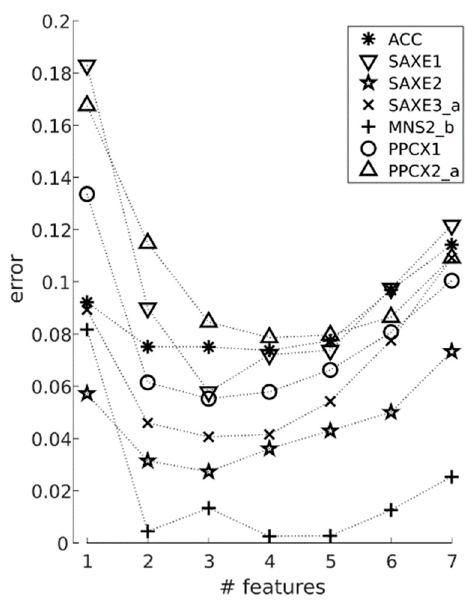
Figure 7. Error curves (expressed as fraction of misclassification) obtained from cross-validation of the support vector machine (SVM) training. The minimum was always reached by employing three or four features.